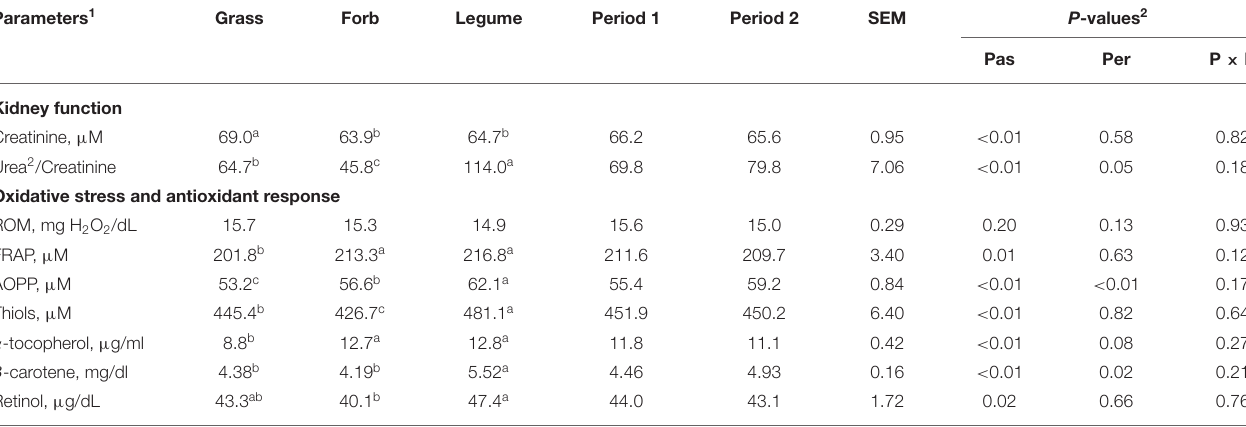
1 ROM, total reactive oxygen metabolites; FRAP, ferric reducing ability of plasma; AOPP, advanced oxidation protein products; 2 Urea data are published elsewhere (Wilson et al., 2020). 2 Pas, effect of type of pasture; Per, effect of the period; P × P, interaction type of pasture and period. Letters a,b,c indicate significant differences between treatments (p <